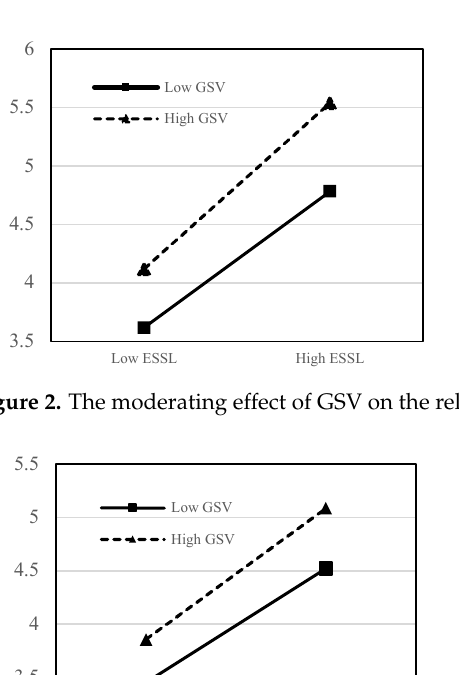
Figure 4. The moderating effect of GSV on the relationship between ESSL and EP. 5. Discussion 5.1. Theoretical Contributions This study provides new insights into the structural linkages of environmentally spe- cific servant leadership (ESSL) and workplace pro-environmental behavior (WPB) based on the proactive motivation model. The results significantly advance the debate on the mechanism of ESSI and WPB in significant ways. First, this study verifies that ESSL can significantly promote WPB based on the pro- active motivation model. The results show that ESSL can guide employees to set clear goals and provide motivation. Employees are guided by ESSL’s example to generate en- vironmental cognition, and by actively seeking and accumulating relevant resources pro- vided by ESSL, the obtained resources are invested in environmental behaviors, and to finally achieve expected environmental behavior. This conclusion is basically consistent with studies such as Aboramadan et al. [64], Luu [35], and Luu [65], which point out that ESSL plays a positive role in promoting organizational green performance and stimulat- ing employees’ green creativity. This inference is consistent with the viewpoint of the so- cial learning theory and the resource conservation theory. Furthermore, this study obvi- ously and significantly extends the conclusions of Xia et al. [2], Luu [36], Luu [33], Mughal et al. [75], Afsar et al. [43], and Afsar et al. [44]. This study provides a new perspective based on the proactive motivation model and integrated social learning theory and re- source conservation theory for the related research of ESSL and WPB and enriches the related literature of ESSL and WPB in the environmental field. Second, this study finds that green self-efficacy (GSE), green organizational identity (GOI), and environmental passion (EP) play multiple mediating roles between ESSL and WPB. This means that ESSL should focus on enhancing employees’ green self-efficacy, improving their green organizational identity, and stimulating their environmental pas- sion, so as to motivate them to actively implement pro-environmental behaviors. In this process, we fill the research gap of the capability, reasoning, and motivation of employees’